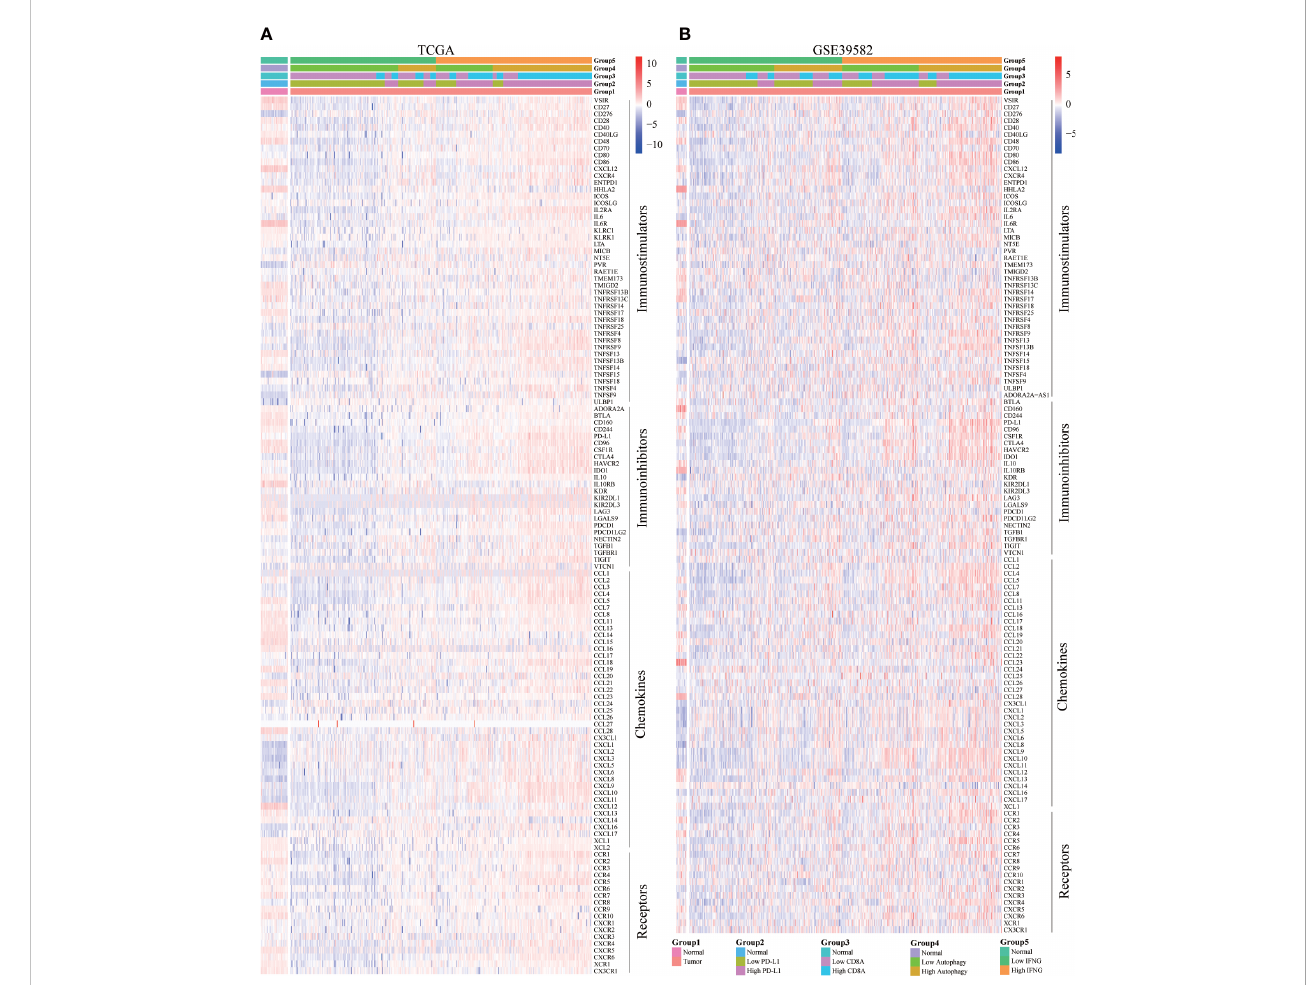
FIGURE 10 Correlation of concrete immune-related genes. In (A) TCGA and (B) GSE39582, the expression of most immune-related genes (immunostimulators, immunoinhibitors, chemokines, and chemokines receptors) in the high IFNG group and high autophagy score group were signi fi cantly